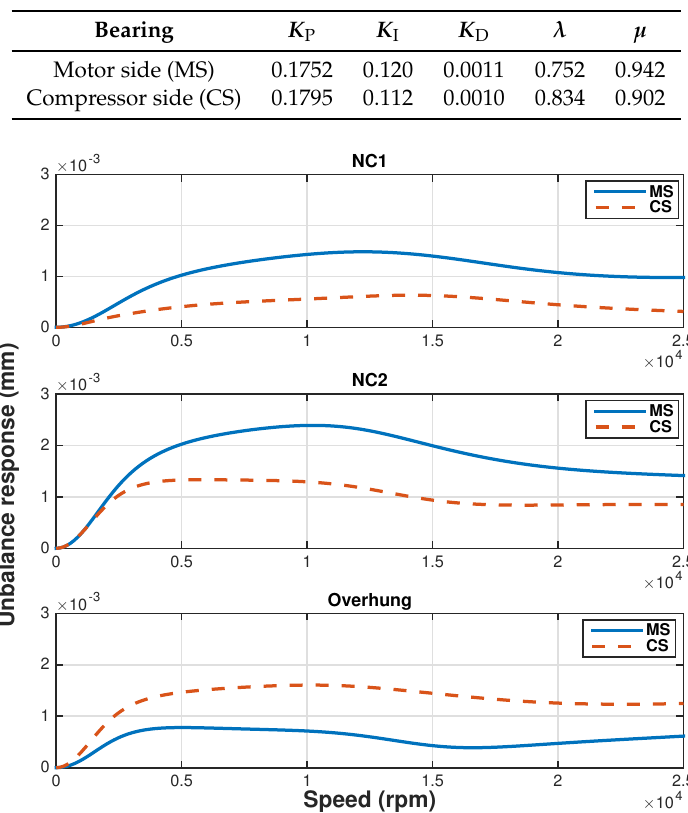
Table 5. Parameters in the FOPID controllers tuned by the DE algorithm.